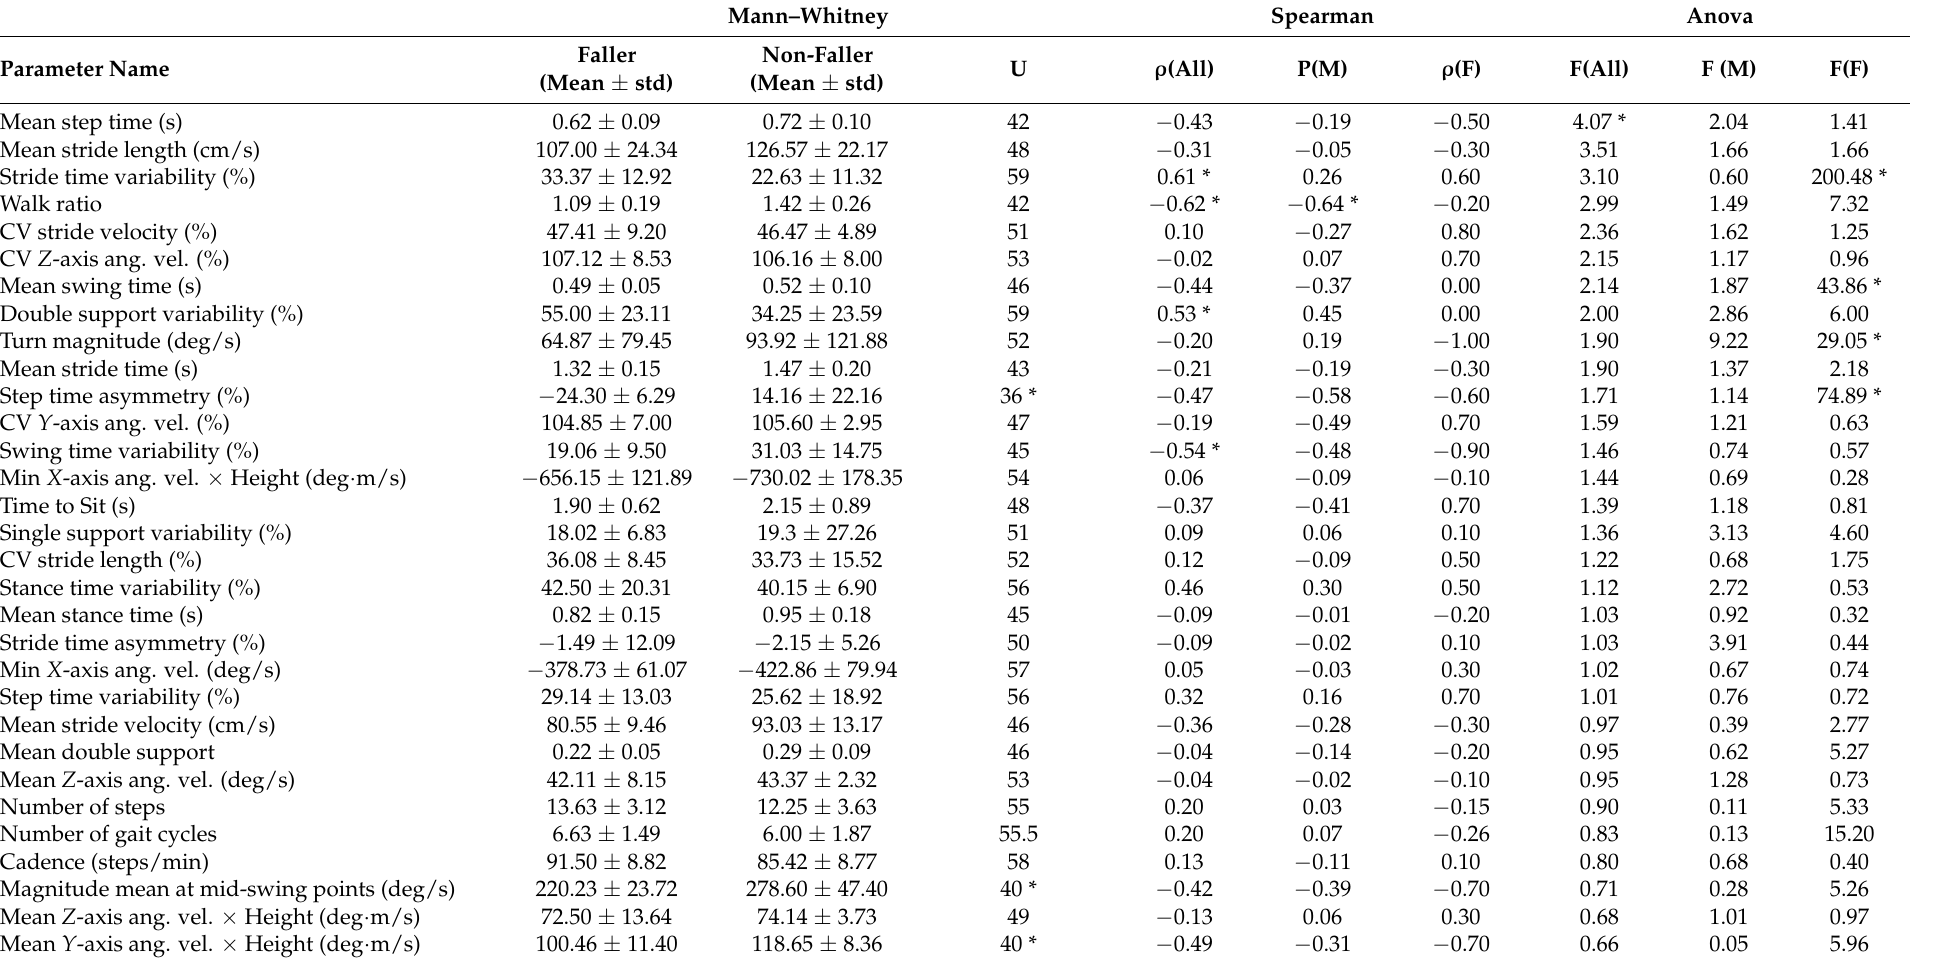
Table A3. Statistical analysis of QTUG parameters with falls counts for PD1 dataset. M and F refer to population stratified by gender. U refers to Mann–Whitney rank sum statistic, ρ refers to Spearman’s correlation coefficient, while F refers to F-score from 1-way Anova test. Statistically significant differences ( p < 0.05) are indicated by